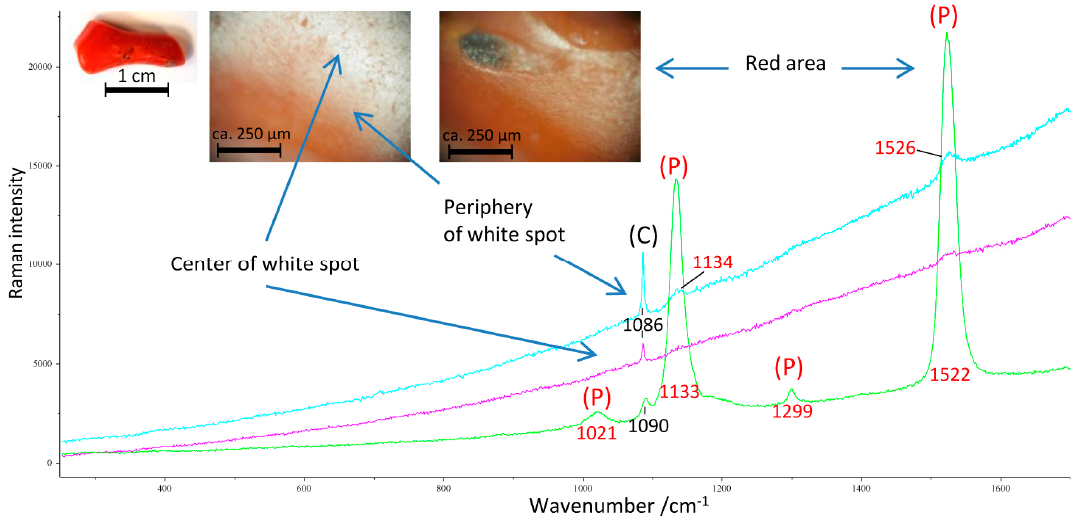
Figure 14. Comparison of Raman spectra from a white spot and from a red part of a single branch of Corallium rubrum from the Mediterranean Sea, all taken with 487.9 nm (Ar + ); (P) stands for polyenes and (C) for calcite.